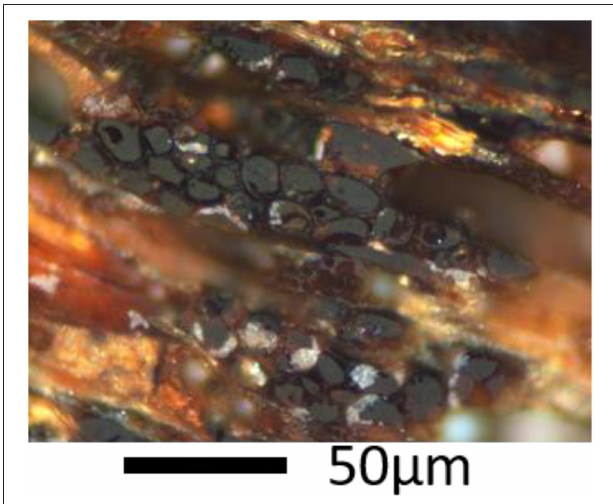
FIGURE 2 | Reflectance image, from polished block under oil, of Sample NNB showing very low reflectance of cell infills (inferred organic) in wood rays seen in tangential longitudinal section. Cell walls either not polished or too thin to measure reflectance. Bright silvery speckly areas within some cell lumina are inferred to be mineral, based on brightness and straight edges (e.g., right of center near base of image). Orange material, some of which may be mineral, is within the block i.e., unpolished.